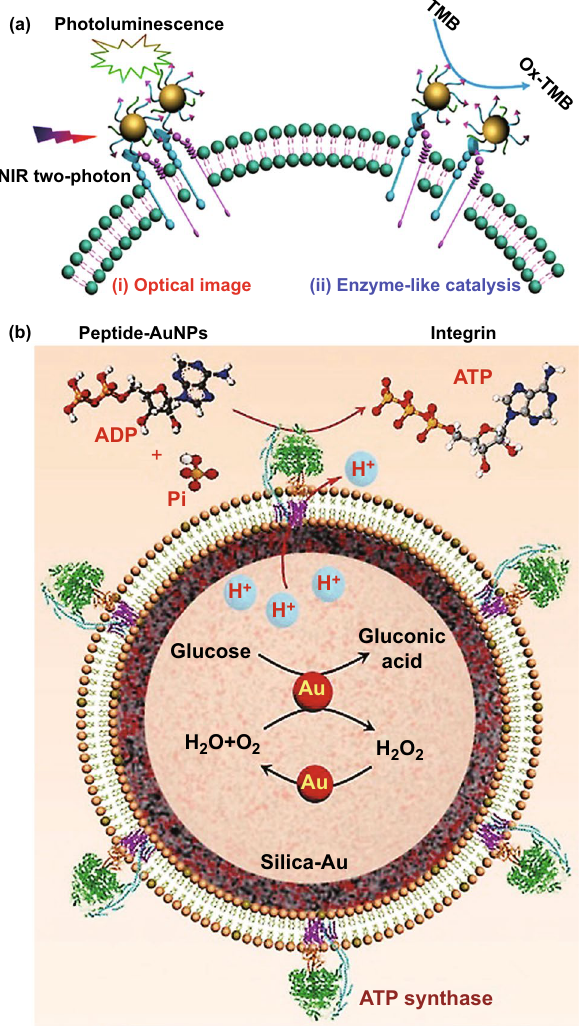
Fig. 13 Cell membrane engineering applications are used for a diag‑ nostics of a health condition [214]. Copyright 2015 American Chemi‑ cal Society or for b mimicking the biological machinery of ATP pro‑ duction in an artificial complex [213]. Copyright 2019 Wiley–VCH Verlag GmbH & Co. KgaA, using in both cases the catalytic proper‑ ties of